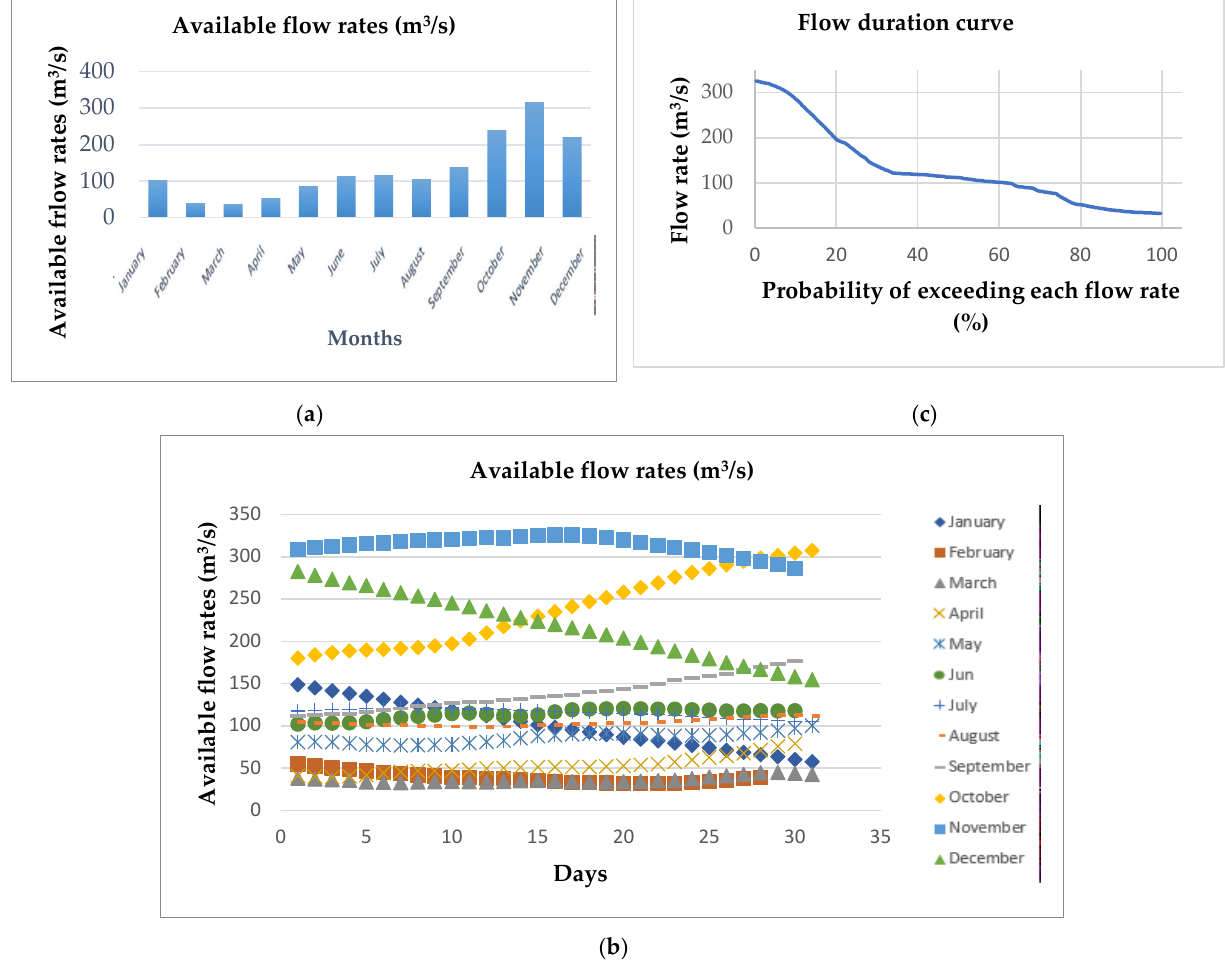
Figure 7. ( a ) Average monthly available flow rates histogram, ( b ) average daily available flow rates curve, and ( c ) flow duration curve of the river Nyong